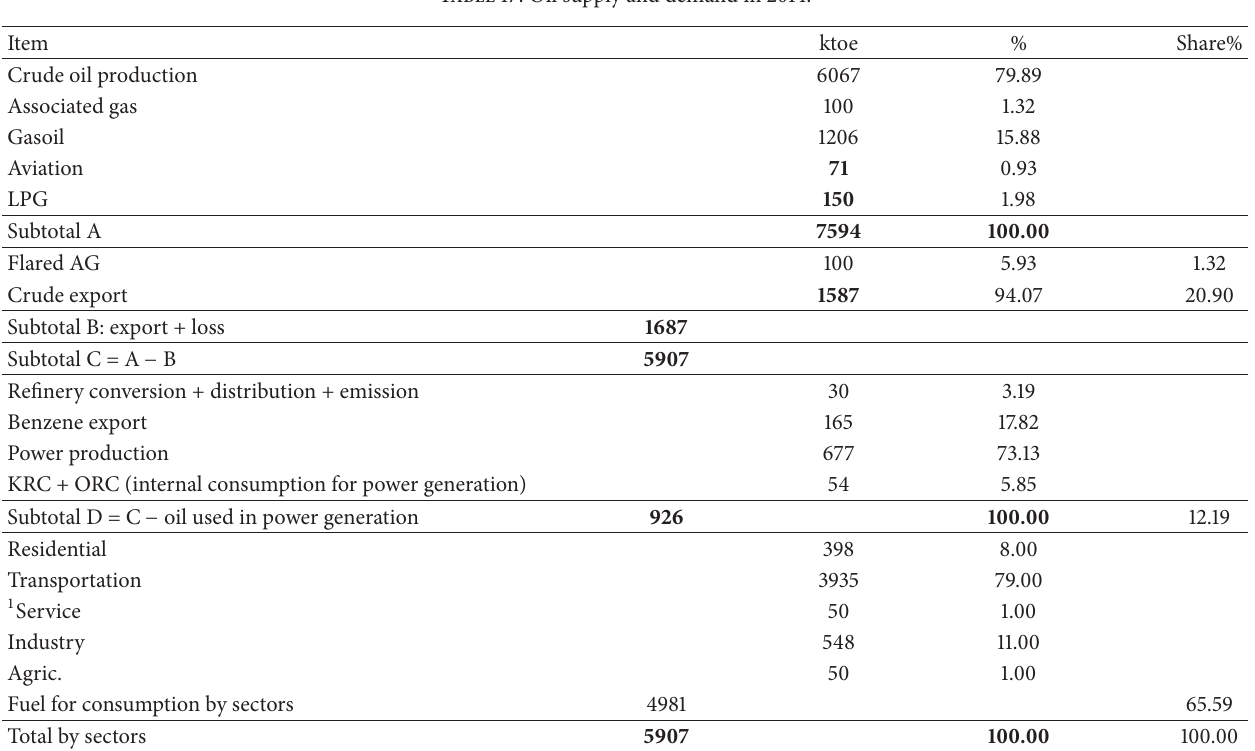
Table 17: Oil supply and demand in